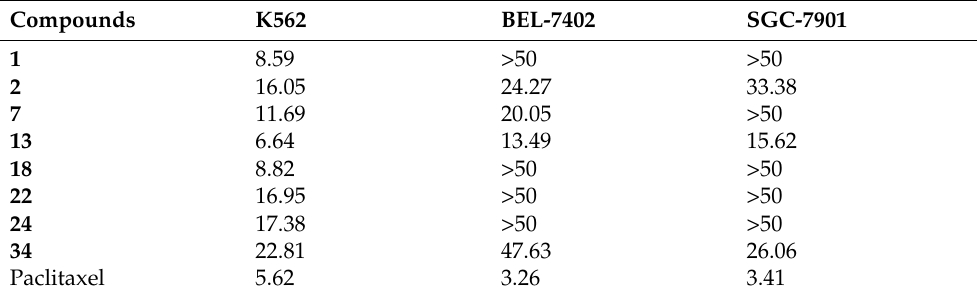
Table 2. Cytotoxic activities of compounds from Ganoderma luteomarginatum (IC 50 , µ g/mL).